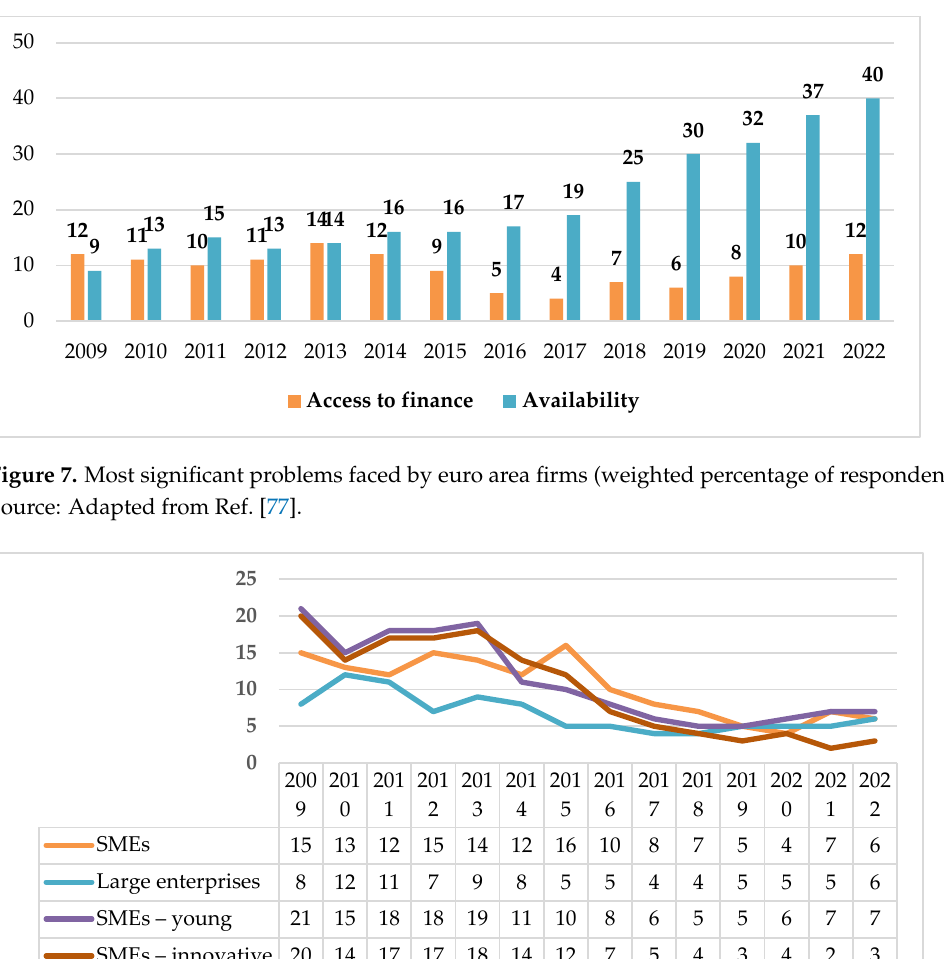
Figure 7. Most significant problems faced by euro area firms (weighted percentage of respondents). Source: Adapted from Ref. [77].